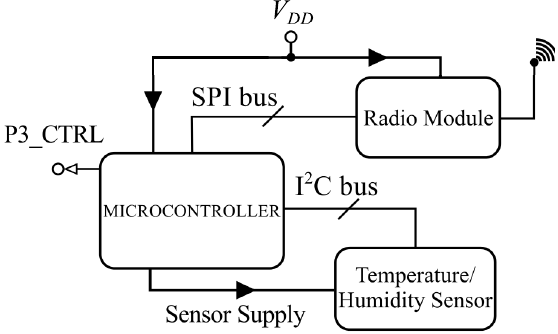
Figure 4. Block diagram of the realized WSN node. Note that the sensor is supplied by a microcontroller. The node consists of a microcontroller, a radio module, and a temperature/humidity